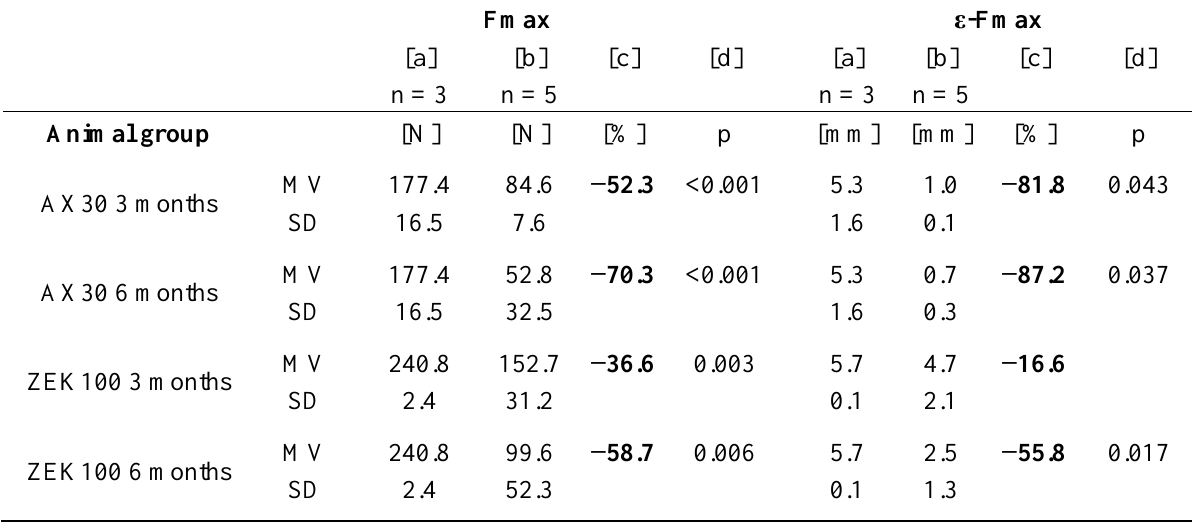
Table 4. Mechanical properties of the implants measured by 3 point bending after